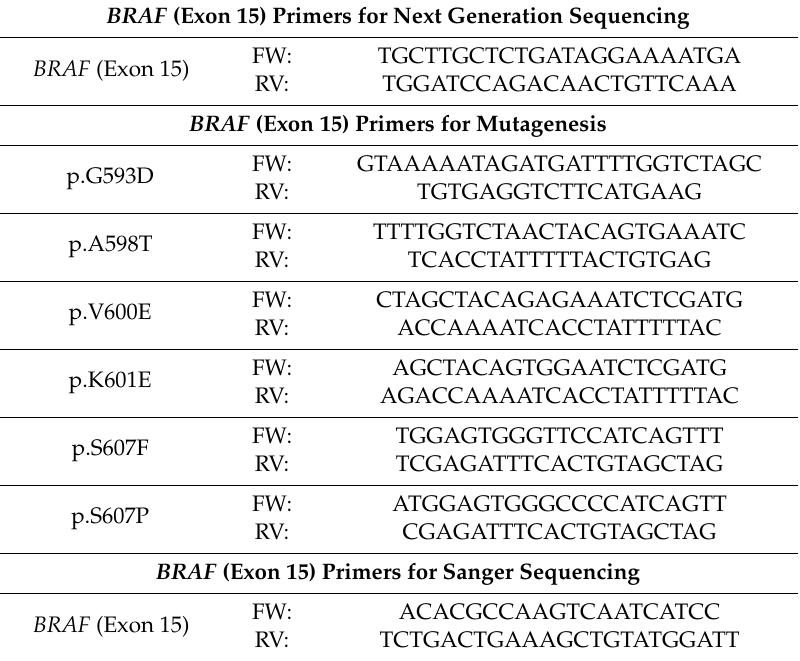
Table 5. Primers used for sequencing and